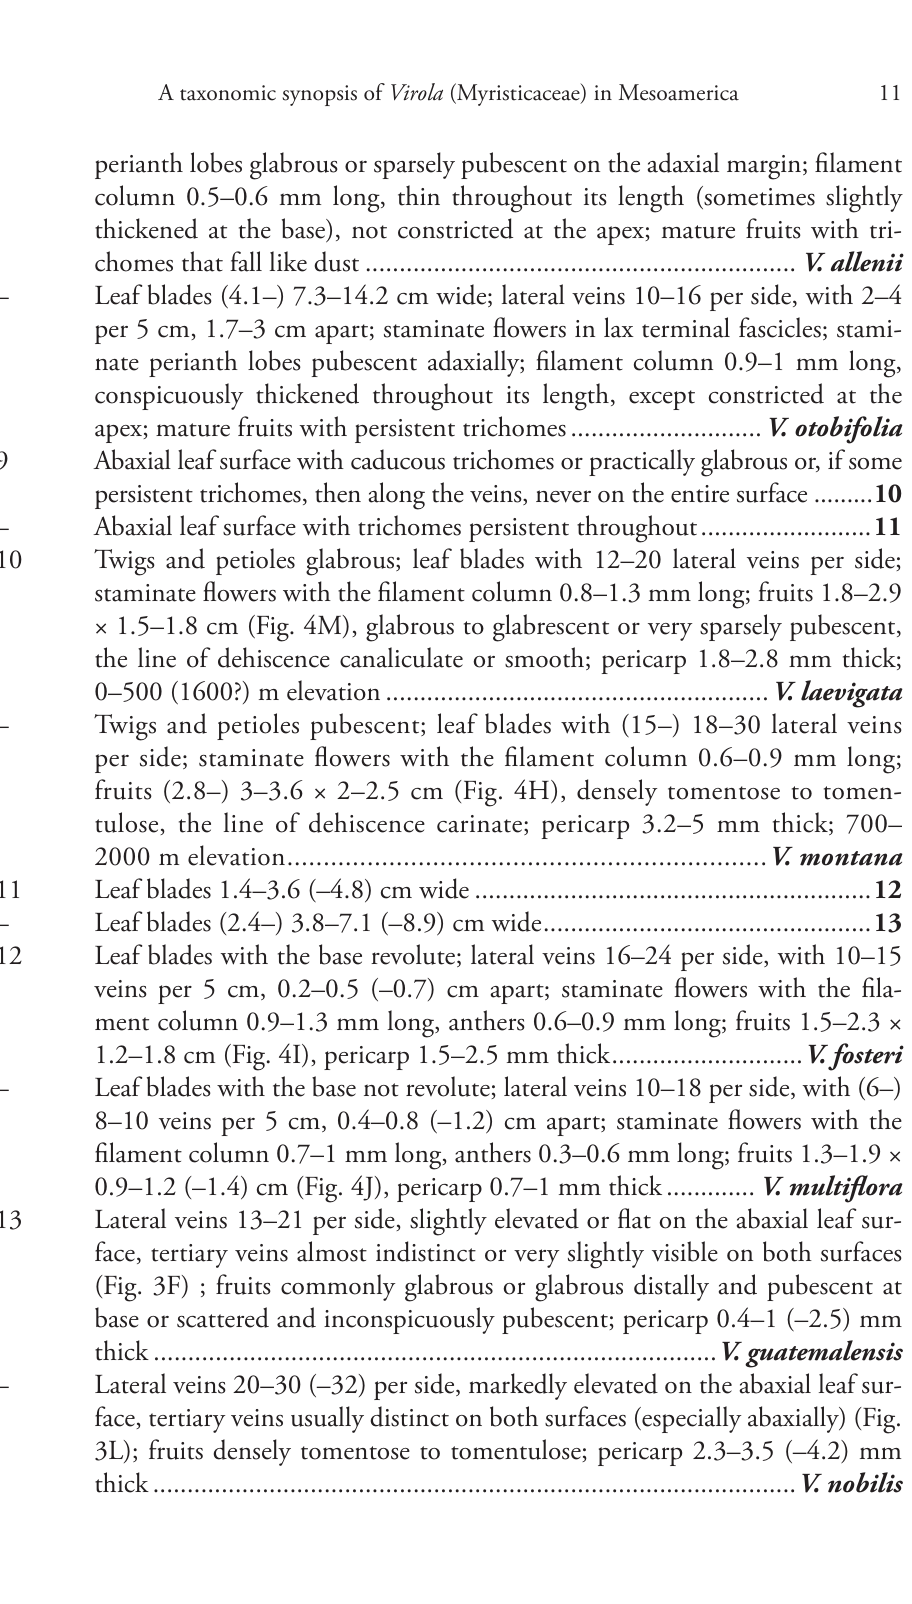
filament column 0.7–1 mm long, anthers 0.3–0.6 mm long; fruits 1.3–1.9 × Lateral veins 13–21 per side, slightly elevated or flat on the abaxial leaf sur- face, tertiary veins almost indistinct or very slightly visible on both surfaces (Fig. 3F) ; fruits commonly glabrous or glabrous distally and pubescent at base or scattered and inconspicuously pubescent; pericarp 0.4–1 (–2.5) mm thick .................................................................................. V. guatemalensis Lateral veins 20–30 (–32) per side, markedly elevated on the abaxial leaf sur- face, tertiary veins usually distinct on both surfaces (especially abaxially) (Fig. thick .............................................................................................. V.